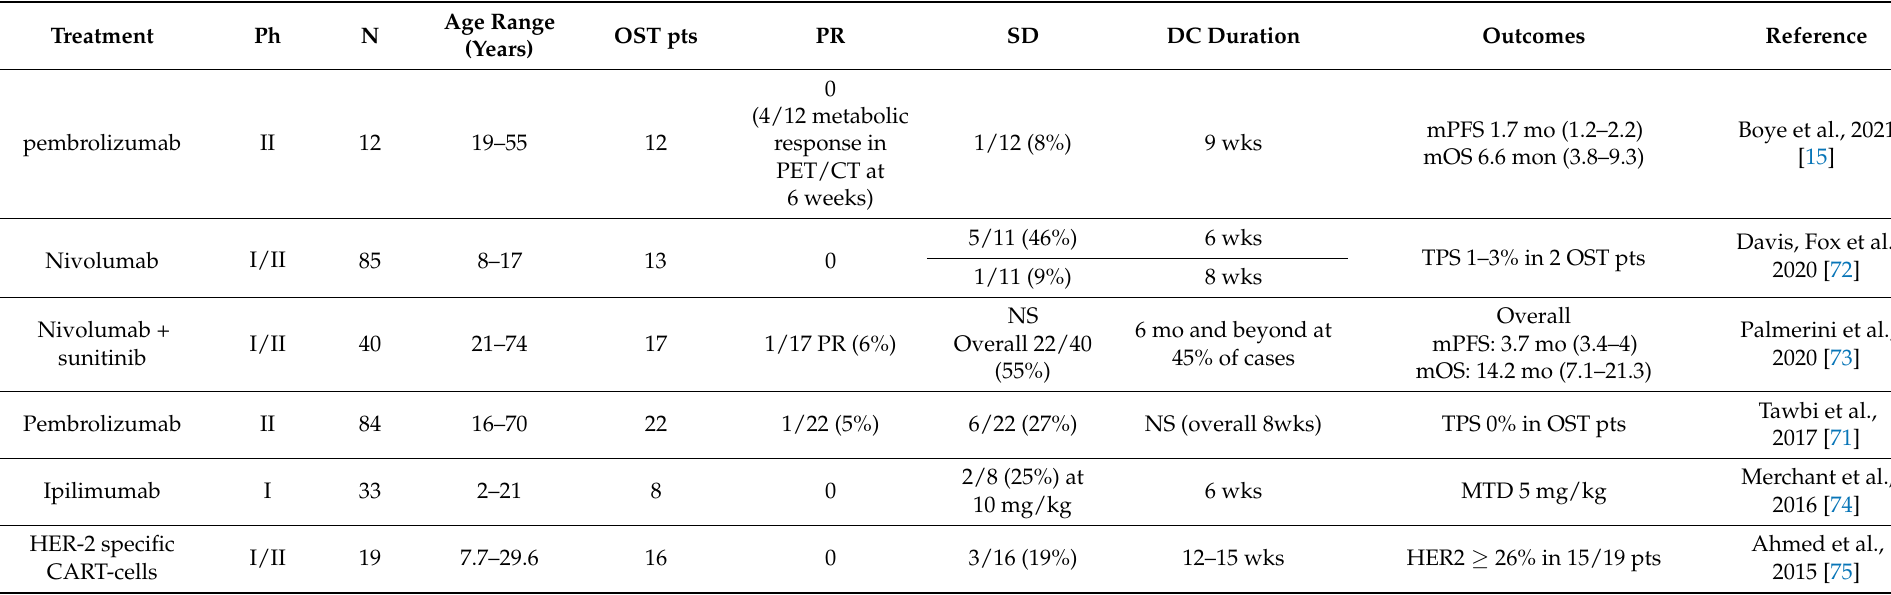
Table 4. Trials employing immunotherapy (6